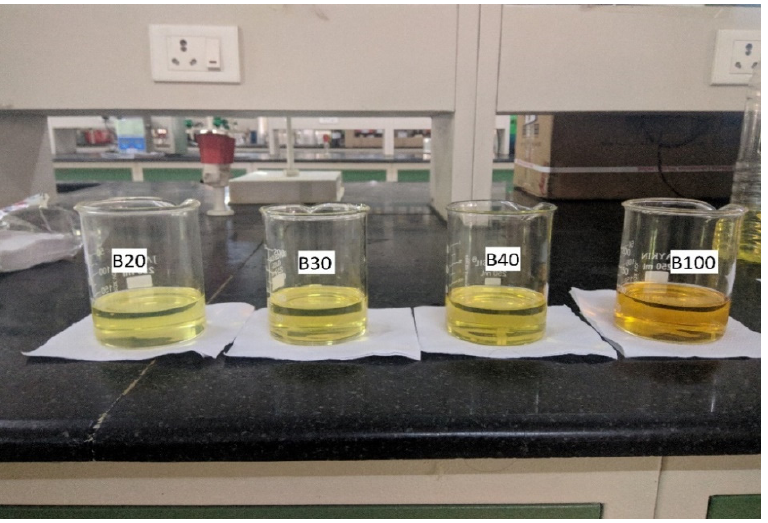
Figure 2. Photographical view of PKO blends.